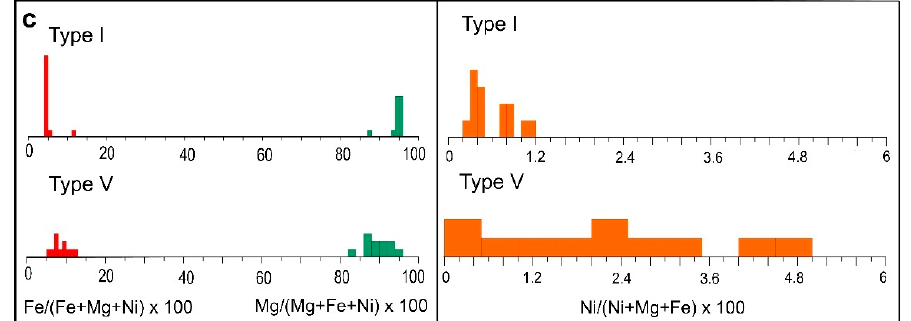
Figure 11. Histogram of Mg (green), Fe (red) and Ni (orange) mol ratio in the different types of serpentine identified in the saprock derived from ( a ) lherzolite ( b ) harzburgite-dunite and ( c ) clinopyroxenite bedrock. Minerals 2020 , 10 , x FOR PEER REVIEW